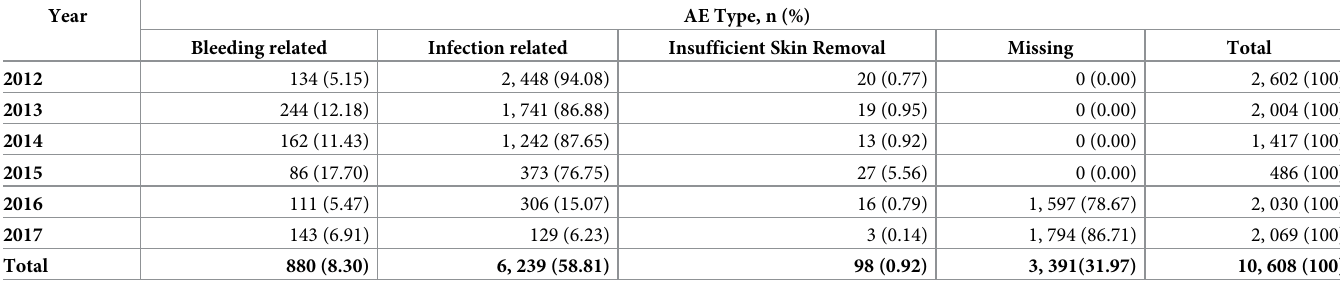
Table 4. Types of Adverse events from